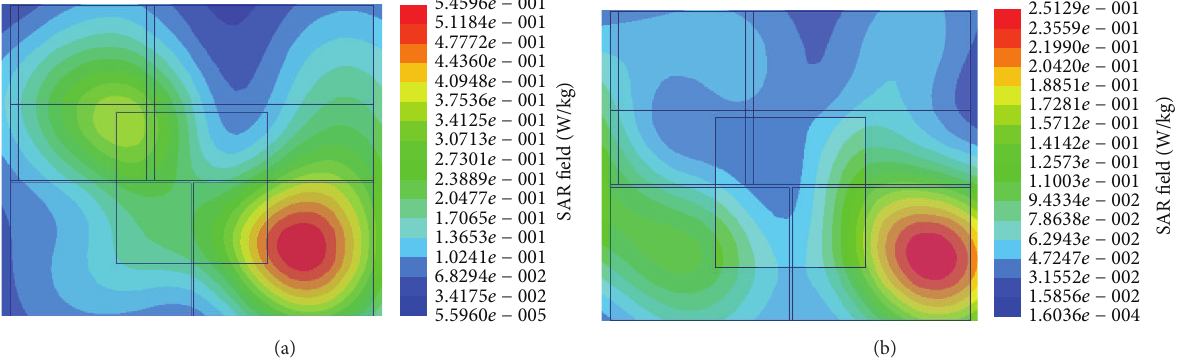
Figure 14: Simulated average SAR distributions of the proposed antenna when placed on the human equivalent phantom (input power: 65 mW): (a) 5.18 GHz and (b) 5.77 GHz.